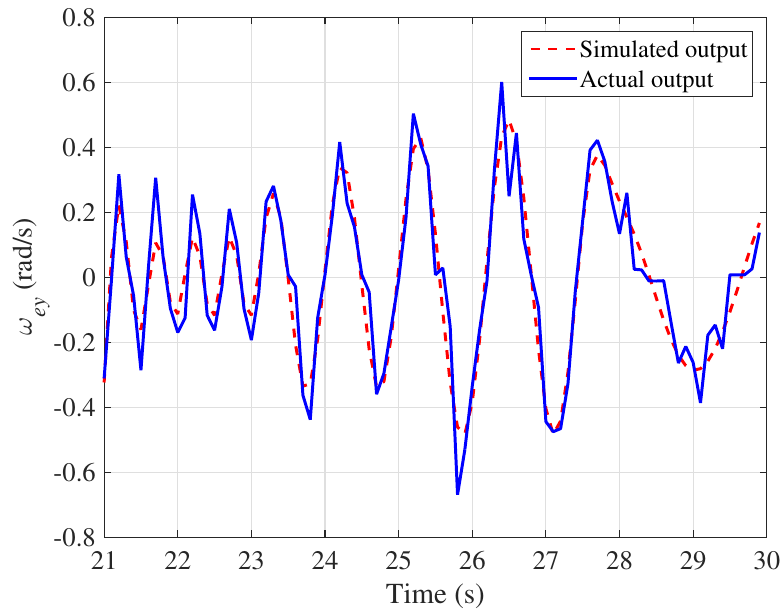
Figure 5. Model validation of elevation